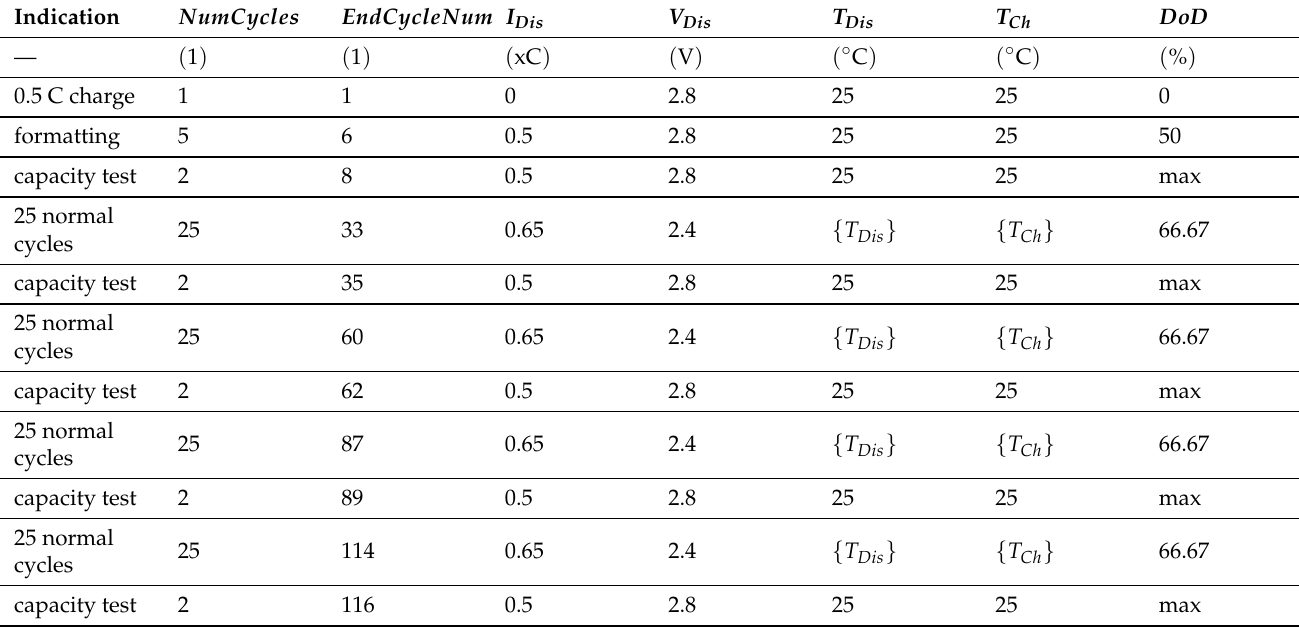
Table 2. Variable parameters of cyclic tests performed in CC discharging mode. Charging is always in CC/CV